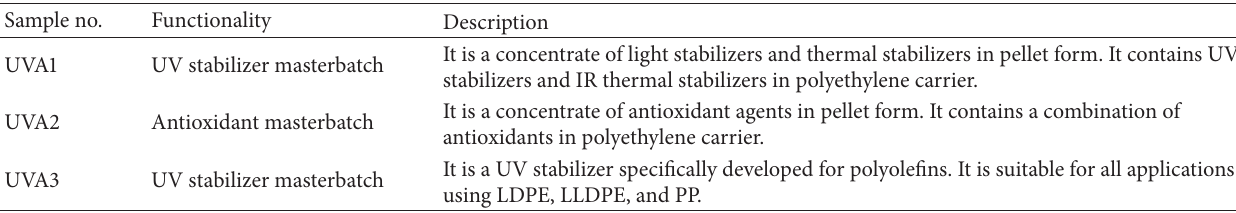
Table 3: List of UV additives used in this study.